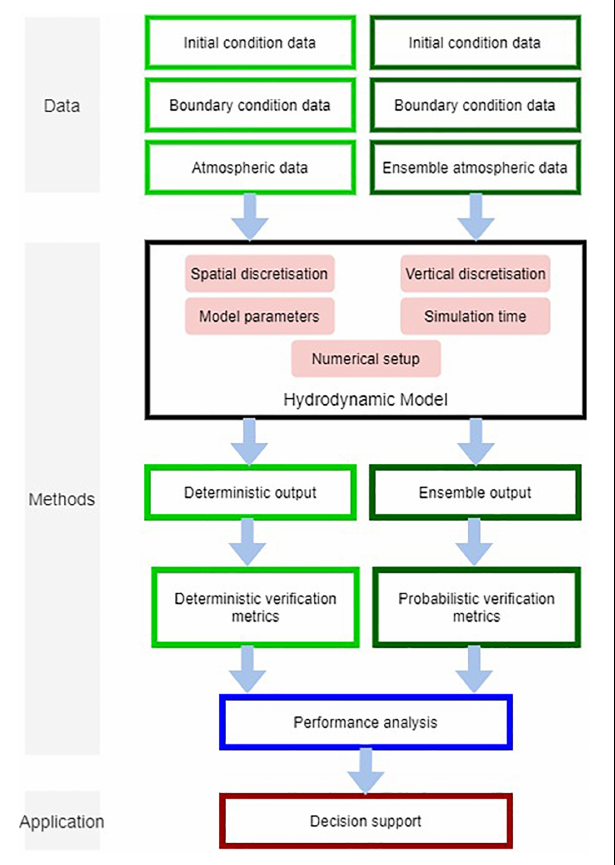
FIGURE 2 | Methodological framework consists three major components – Data, Methods, and Application. There are two main models setups that are followed. Left side track (light green) represents the deterministic model and the right side track (dark green) represent the ensemble model.